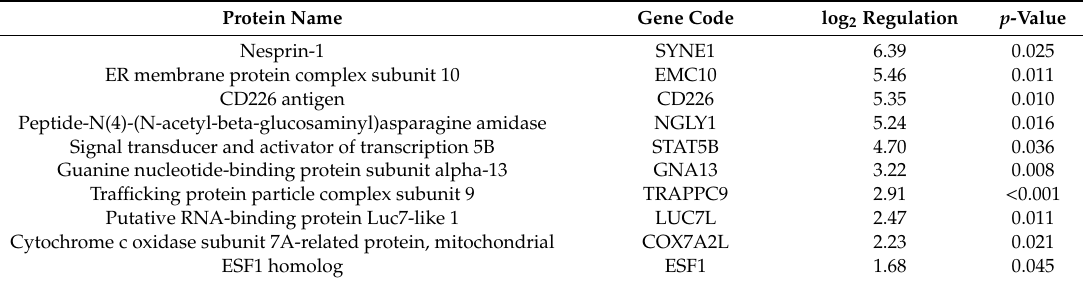
Table 4. Strongest upregulated proteins after EPX treatment.